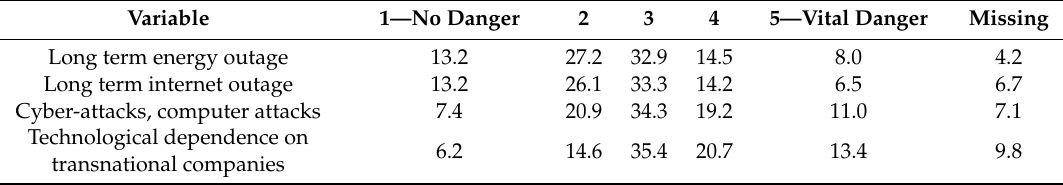
Table 2. The distribution of the respondents over 5 categories on the perceived dangers,